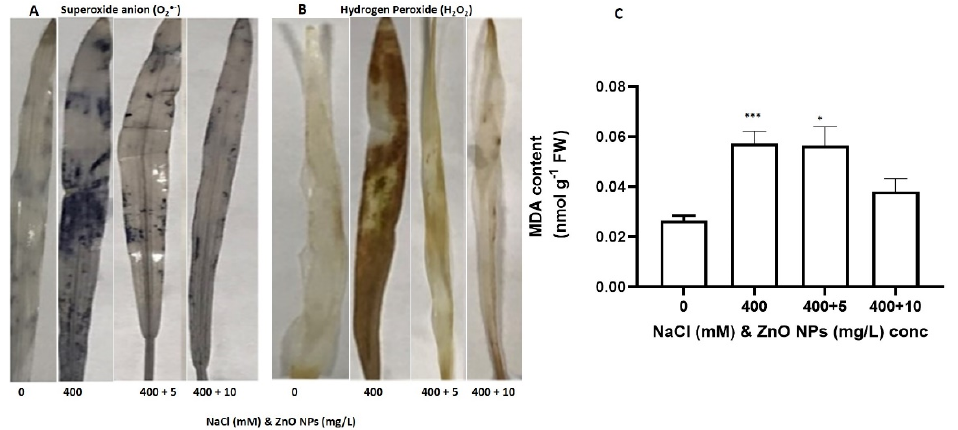
Figure 4. Effect of salt and the priming of ZnO NPs on ROS (O 2 • - and H 2 O 2 ) accumulation and MDA content in sorghum. Histochemical detection of ( A ) O 2 • - and ( B ) H 2 O 2 . ( C ) Measurement of MDA content in salt-treated plants and salt-treated plants primed with ZnO NPs. Error bars represent the SD calculated from three biological replicates. Statistical significance between control and treated plants was determined by a two-way ANOVA performed on GraphPad 9.2.0, shown as *** = p ≤ 0.001 and * = p ≤ 0.05 according to the Bonferroni’s multiple comparisons test. Malondialdehyde content was measured to determine the extent of the oxidative damage on membrane lipids (Figure 4C). The results showed that a high salt concentration (400 mM NaCl) significantly increased MDA content by 115.38% as compared to the control. This indicates that salt stress caused significant and serious damage to sorghum